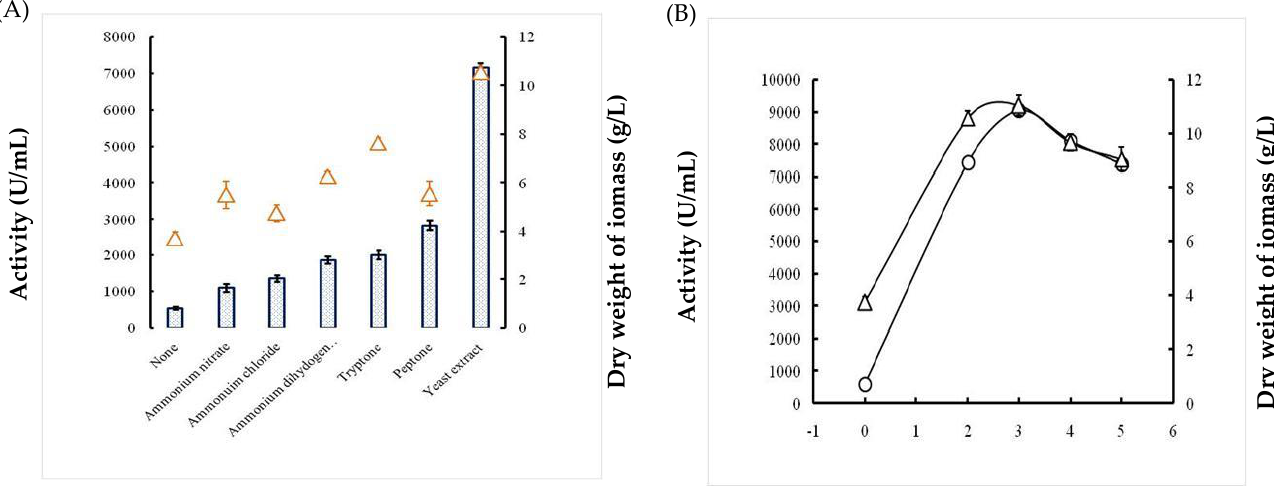
Figure 3. Effects of nitrogen source ( A ) and selected yeast extract concentration ( B ) on growth (triangles) and protease production (bars) from Bacillus stearothermophilus . Data are expressed as mean ( n = 3) ± SD.